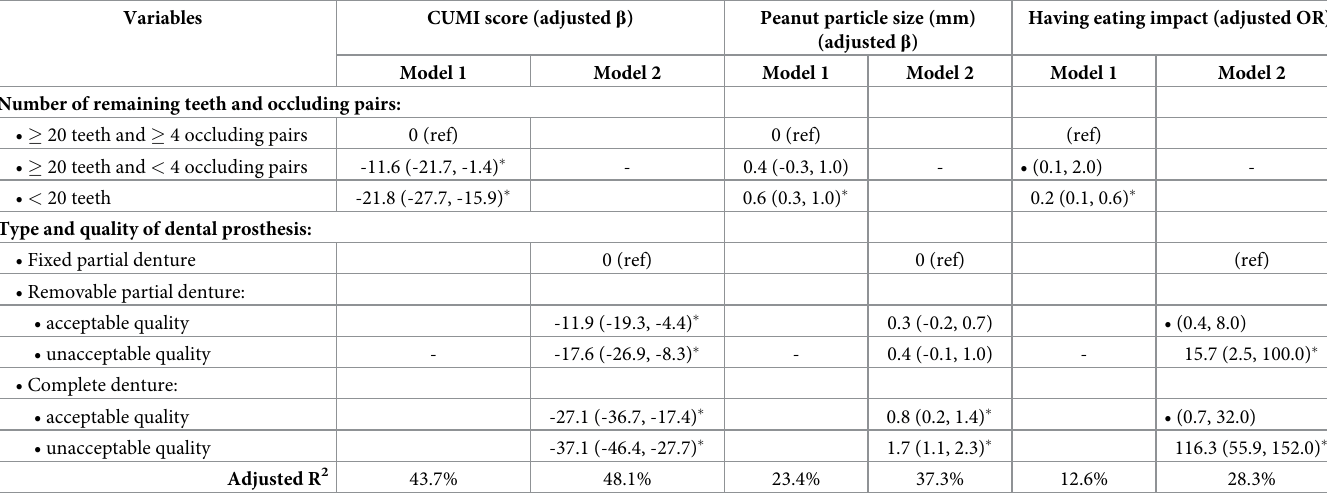
Table 3. Multivariable analyses of masticatory ability measures and relating variables. Variables